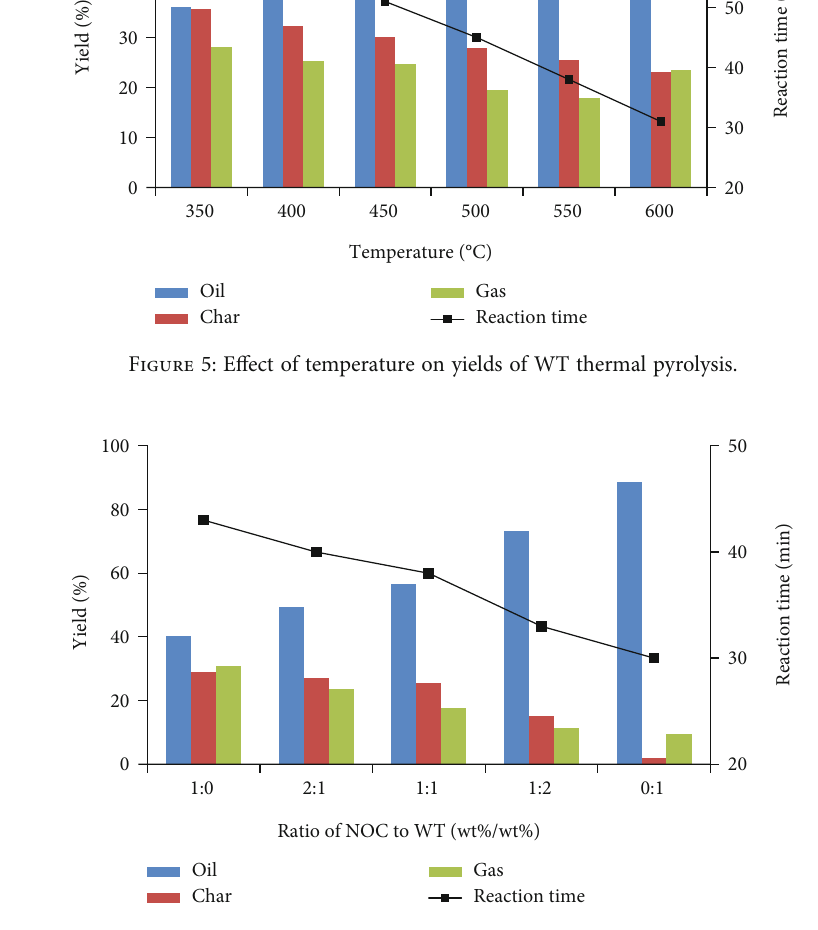
Figure 6: E ff ect of blending ratio on